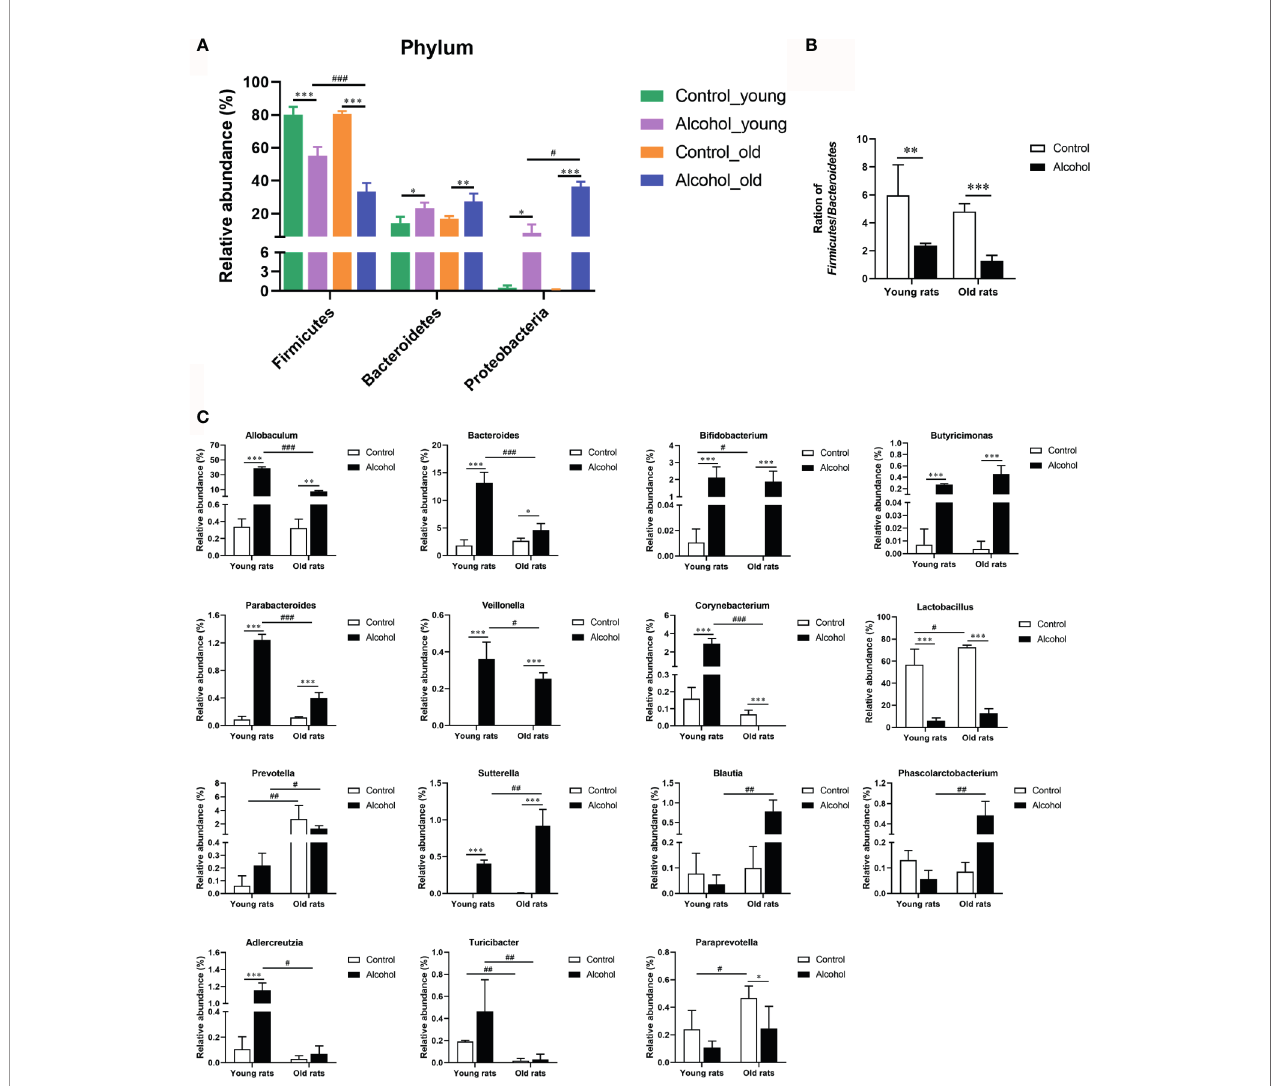
FIGURE 7 | Effects of alcohol on the micro fl ora in fecal stool samples of young and old rats. (A) The relative abundance of each phylum; (B) The ration of Firmicutes/Bacteroidetes; (C) The relative abundance at the genus level. Data were shown as mean ± SD. n=3, * P < 0.05, ** P < 0.01, *** P < 0.001, compared with control of the same age; # P < 0.05, ## P < 0.01, ### P < 0.001, the same group compared with young